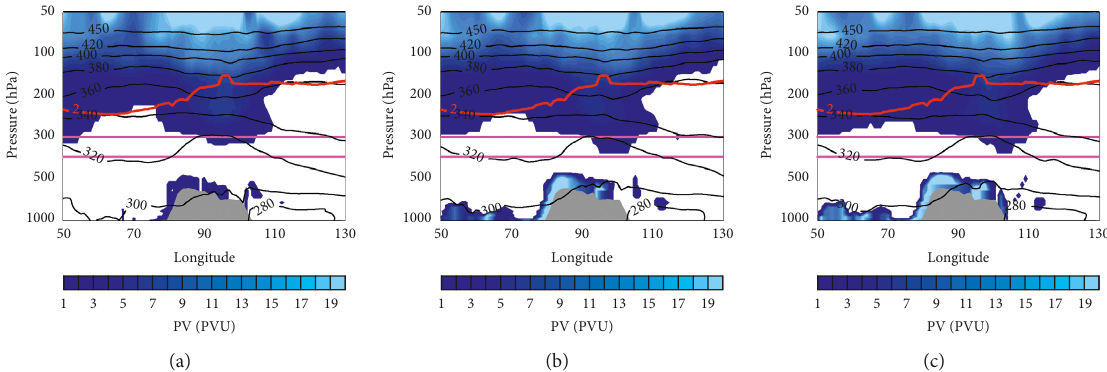
Figure 10: Pressure-longitude cross section of PV (color shadings; pvu) and potential temperature (black lines; K) at 30 ° N at 12:00 UTC 29 December 2018 (a), 18:00 UTC 29 December 2018 (b), and 00:00 UTC 30 December 2018 (c). The red lines denote the mean 2pvu contour at 30 ° N in December between 1979 and 2018. Pink lines represent 300hPa and 400hPa surfaces. The area shaded in gray indicates the TP terrain.